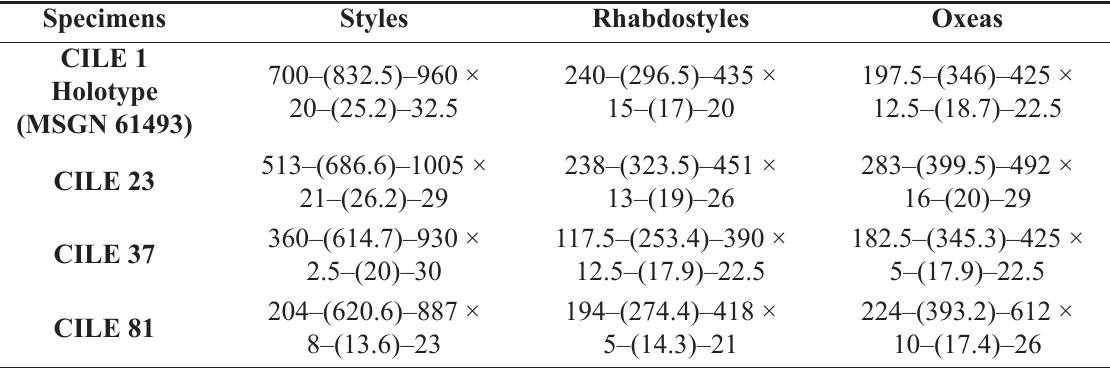
Table 4. Comparison of spicule dimensions (in μm) among specimens of Axinella cylindrica Bertolino, Costa & Pansini sp.